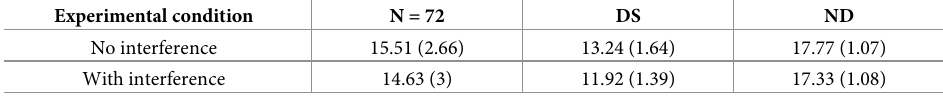
Table 3. Experimental task by interference: Mean (standard